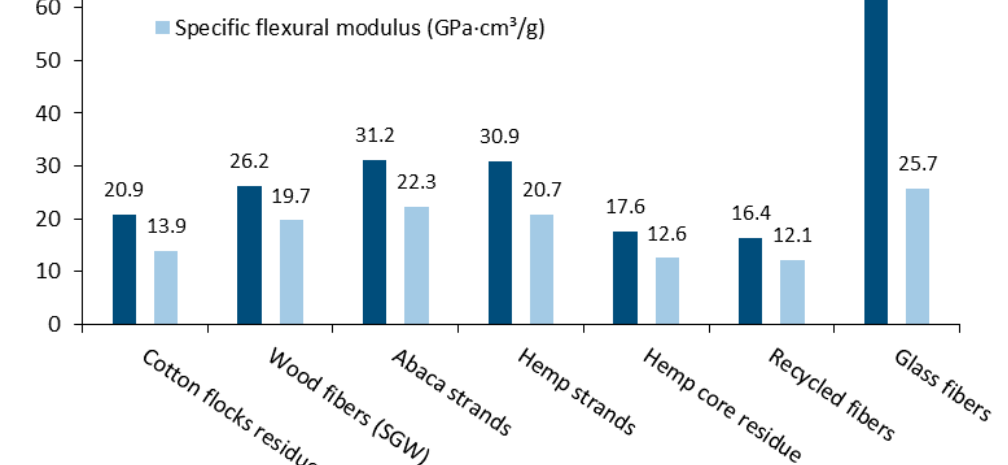
Figure 6. Flexural modulus and specific flexural modulus of different fiber-reinforced PP composites (wood fibers [52], abaca strands [53], hemp strands [61], hemp core residues [54], recycled fibers [32], and glass fibers [53]).